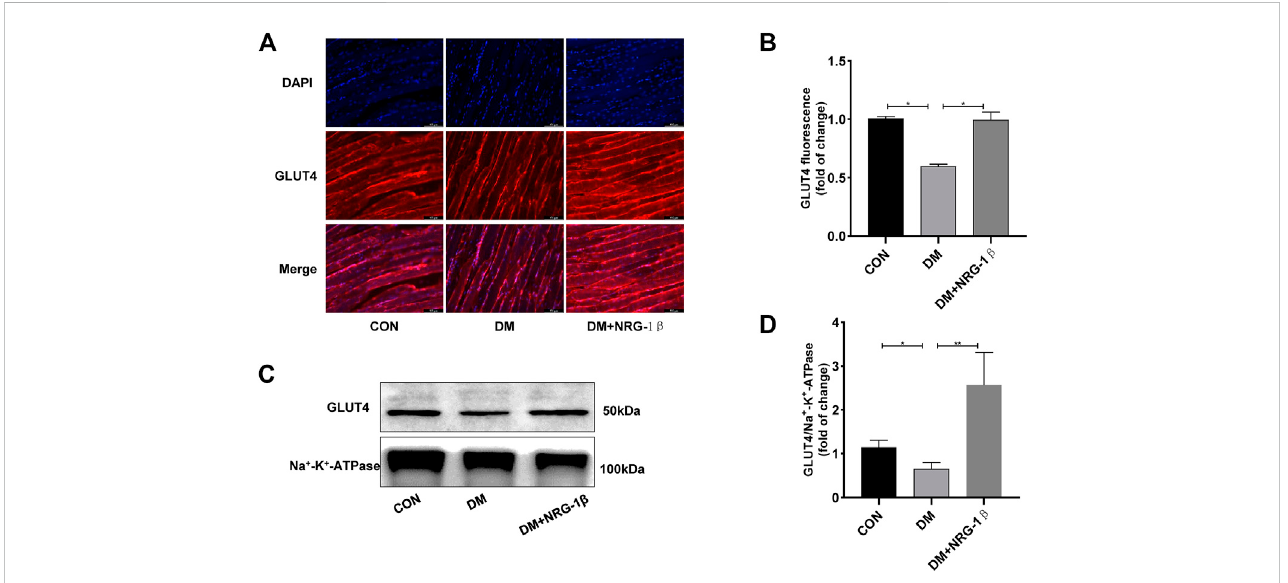
FIGURE 6 NRG-1 β promoted the translocation of GLUT4 in the skeletal muscle of T2DM mice. Effects of NRG-1 β on gastrocnemius GLUT4 translocation, GLUT4 was detected by using a fl uorescent anti-GLUT4 antibody (Scale bar: 100 μ m) (A,B) and Western blotting (C,D) . The data are presented as the mean ± SEM. * p < .05; ** p <